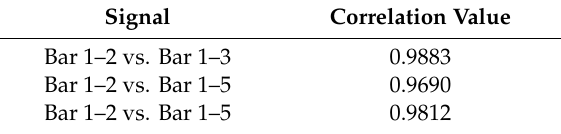
Table 3. Pearson correlation coe ffi cient values between output signals with two broken